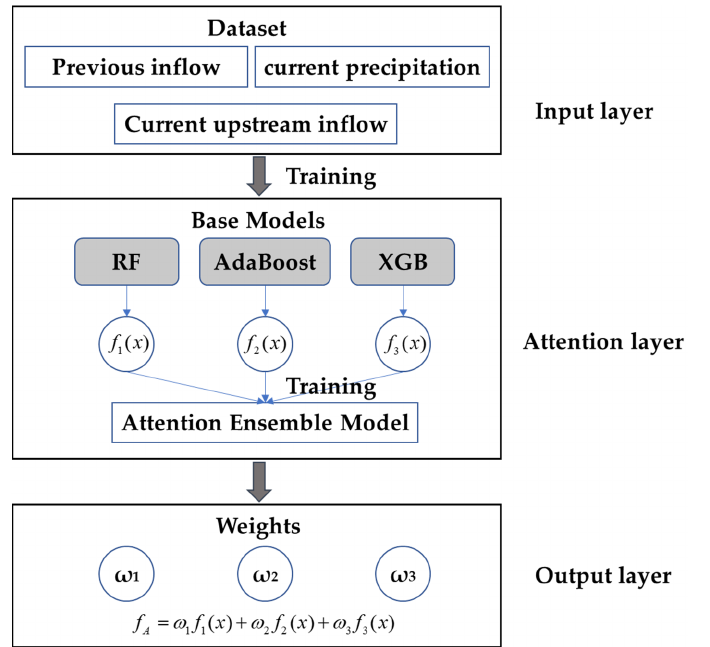
Figure 2. Flow chart for the construction of the proposed attention ensemble model in this study.